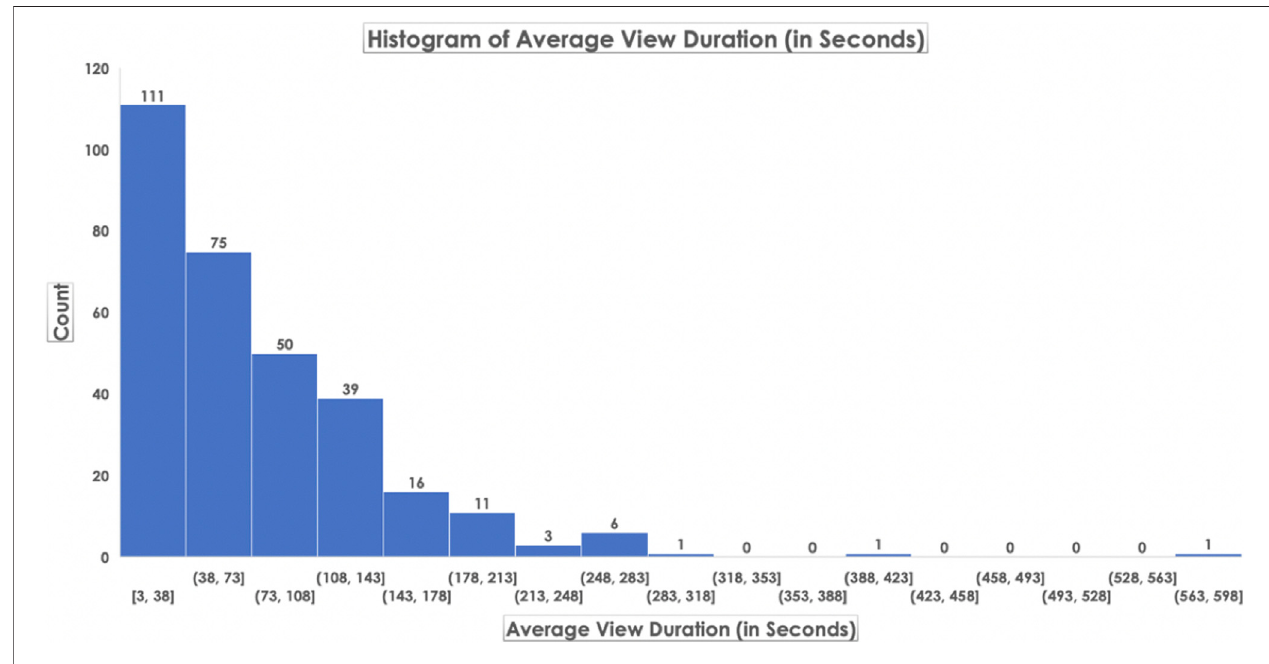
FIGURE 5 | Frequency of average view duration (in seconds in 2020).